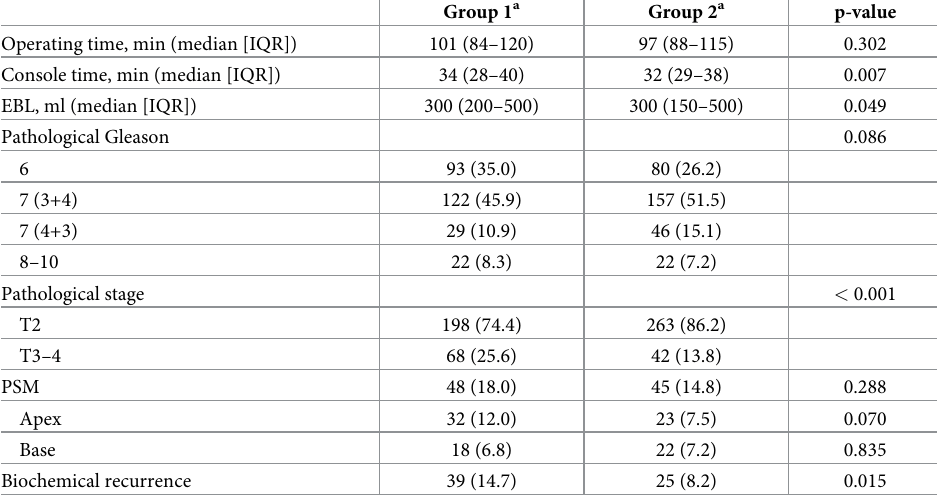
Table 2. Intraoperative variables, pathological data, and biochemical